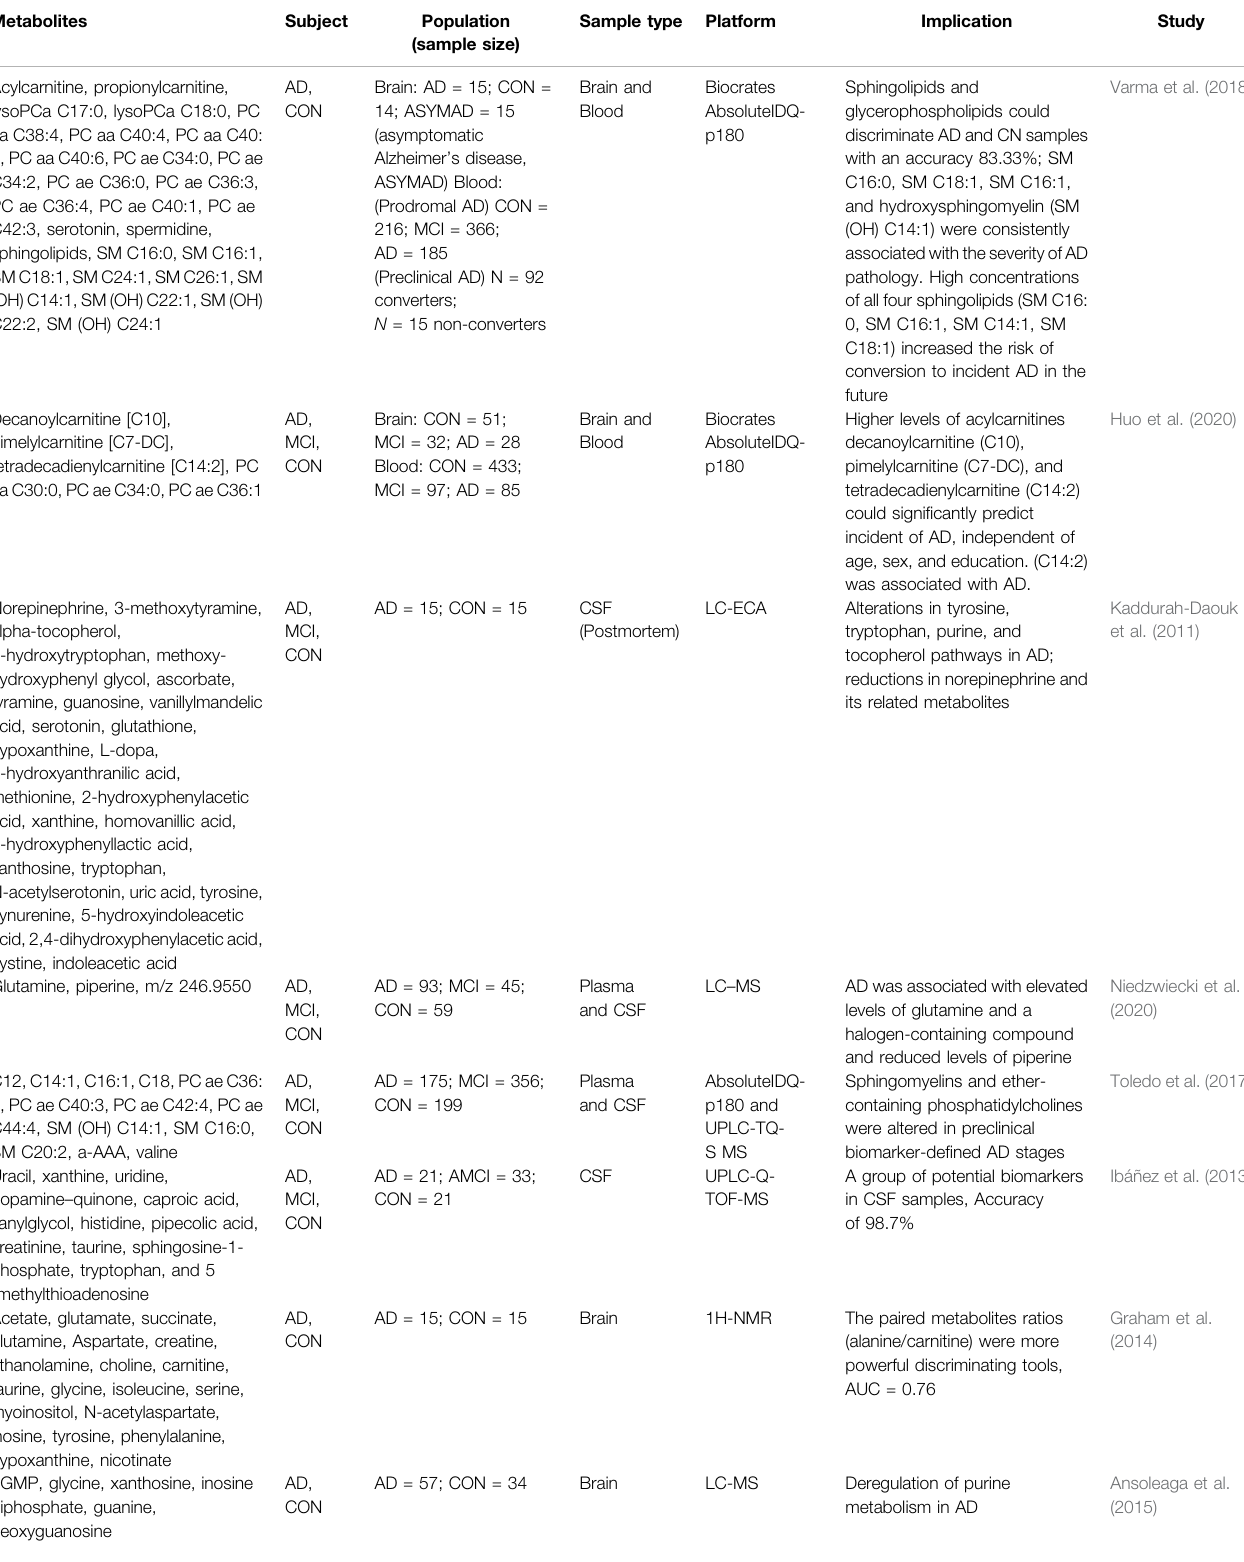
TABLE 3 | Metabolic biomarker in brain or CSF for Alzheimer ’ s disease patients in clinical. Metabolites Subject Population